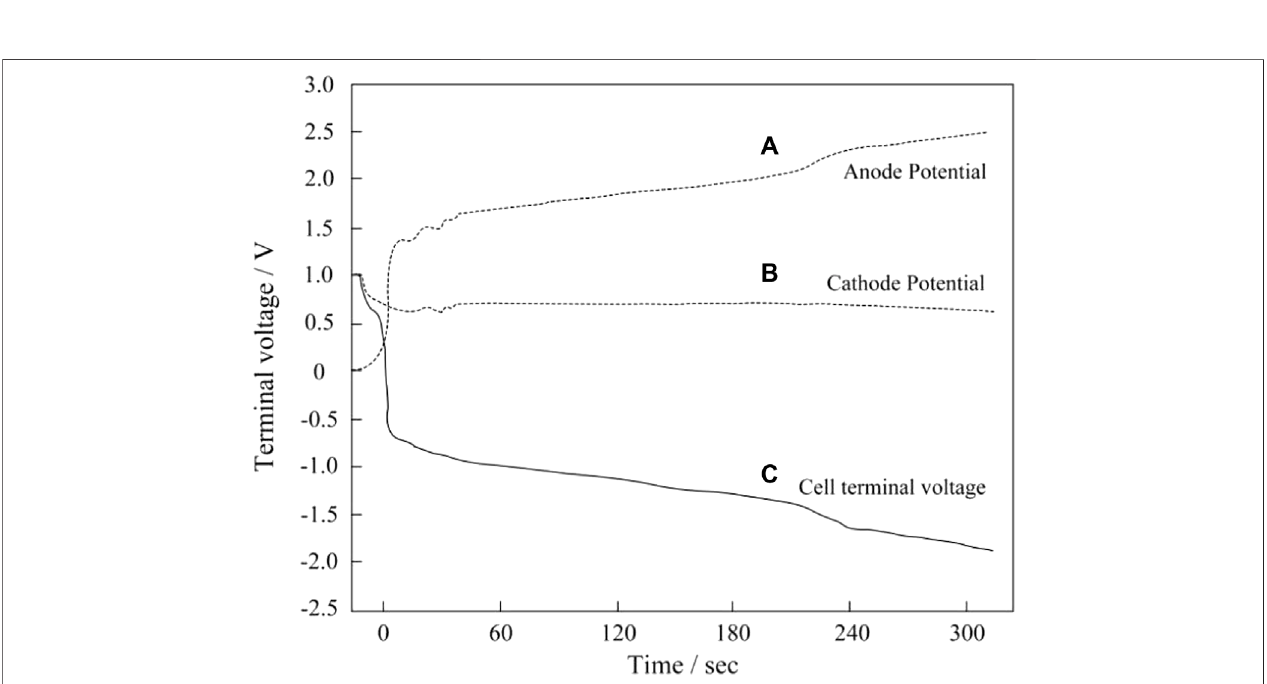
FIGURE2| Potentialpro fi leofthesinglecellduringthesimulatedcellreversalevent.Reproducedwithpermission(Taniguchietal.,2004).Copyright2004,Elsevier.